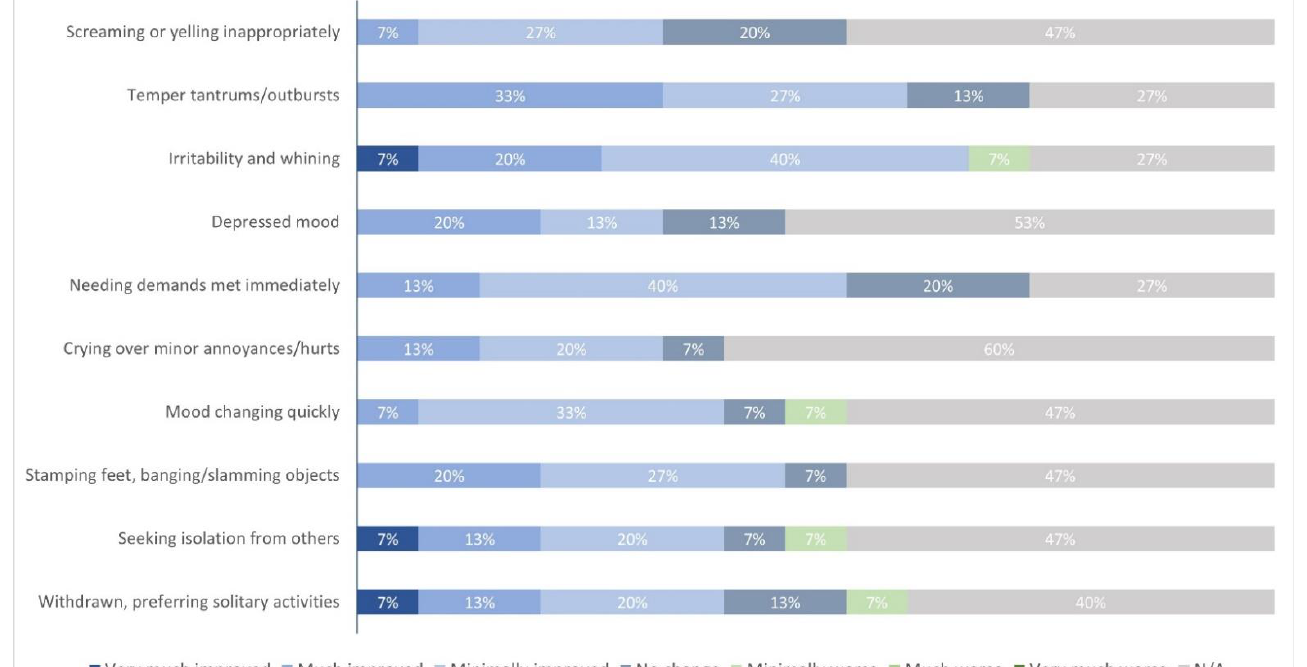
Figure 2. Changes in behaviors with the use of CBD. Footnote: Intellectual Developmental Disability (IDD); Autism Spectrum Disorder (ASD). Table 4. Overall improvement from CBD of symptoms and how caregivers would feel if they had to stop CBD